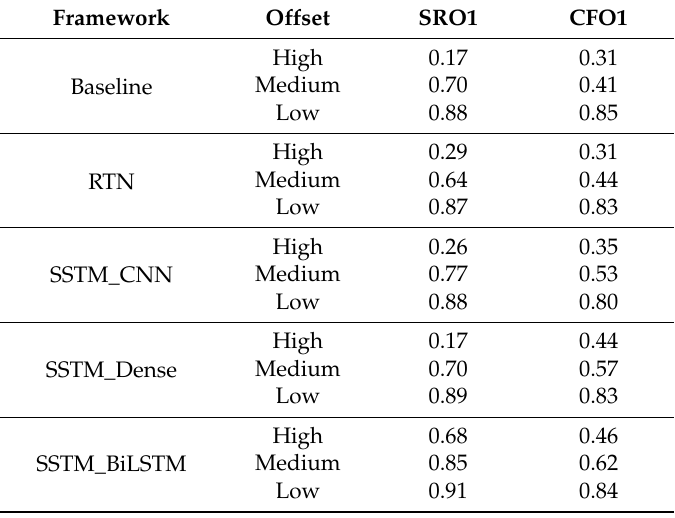
Table 5. Performance comparison for methods versus typical offsets in SRO1 and CFO1 scenarios.